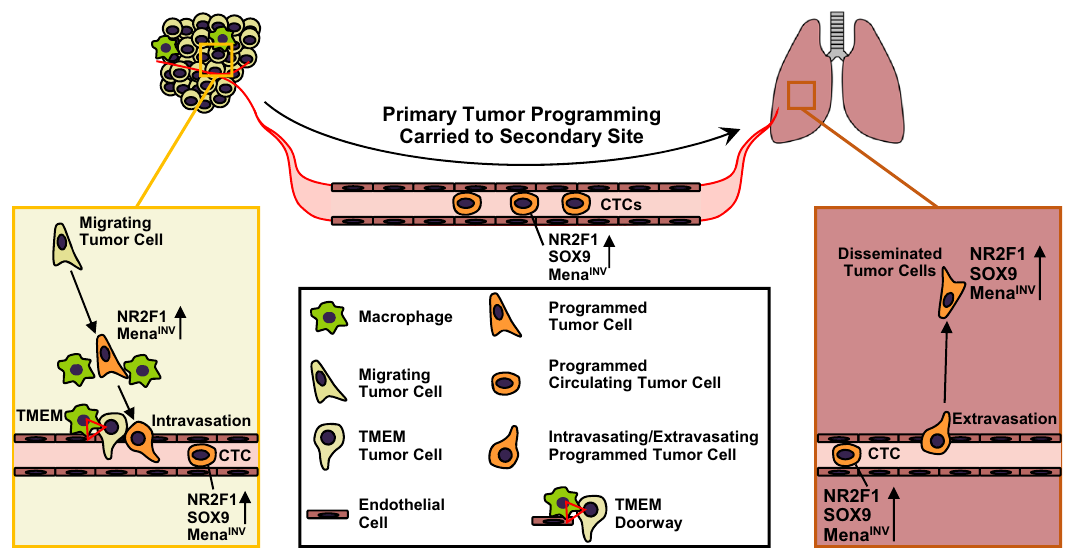
Fig. 9 Model illustrating how the presence of a primary tumor programs disseminated tumor cells for stemness and dormancy at the secondary site. Left Panel: Within the primary tumor, migrating tumor cells are attracted to blood vessels. As they approach TMEM doorways (red triangle) on the vasculature, these tumor cells interact with macrophages and programs of dormancy (NR2F1) and invasion (Mena INV ) are activated. Dormant cells also adopt cancer stem cell properties (SOX9). These cells then intravasate through TMEM doorways into the vasculature and become circulating tumor cells (CTCs). Right Panel: CTCs retain these programs at the secondary site where the invasion program (Mena INV ) facilitates extravasation. The dormancy program expressed by these disseminated tumor cells (DTCs) keeps them as single